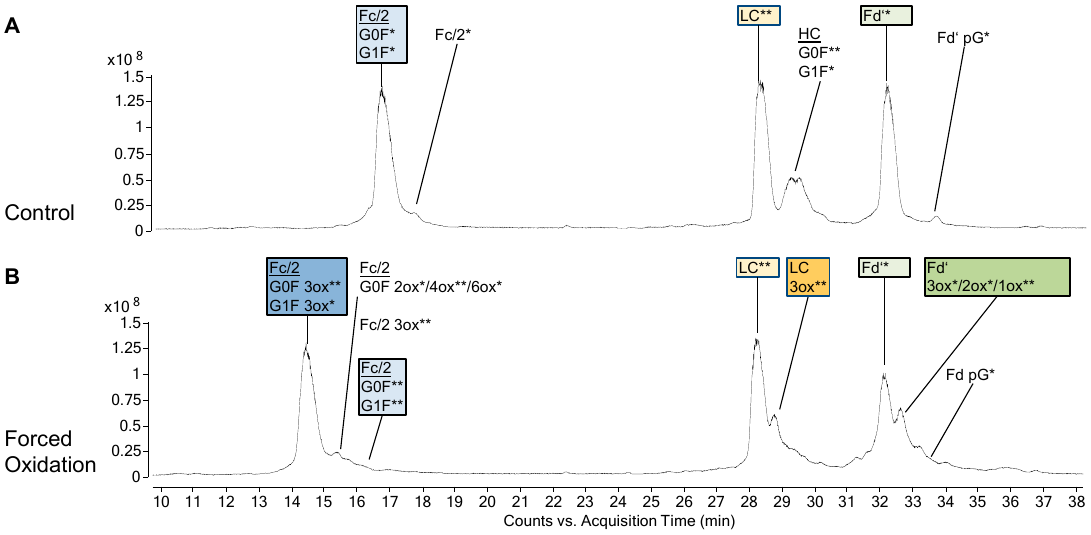
Figure 1. Species identified in biosimilar (BS) of bevacizumab after 48 h of control treatment ( A ) or forced oxidation ( B ). Annotations show the different protein species and their modifications in the chromatographic peaks as identified by their mass. The mass difference between the observed mass and the theoretical value is indicated as follows: 0 to 0.5 Da = *, 0.6 to 1.5 Da = **, 1.6 to 4.0 Da = ***. Ox, oxidations; pG, pyroglutamate modification. Coeluting species within one annotation are listed in order of spectrum intensity.